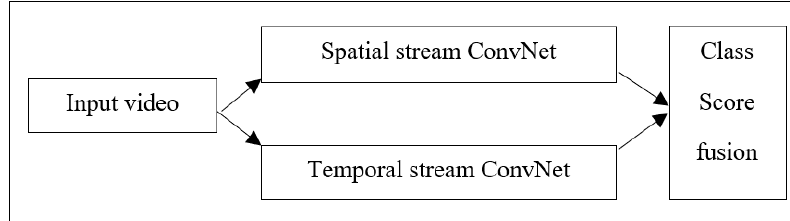
Figure 1. Two-stream network architecture [43].